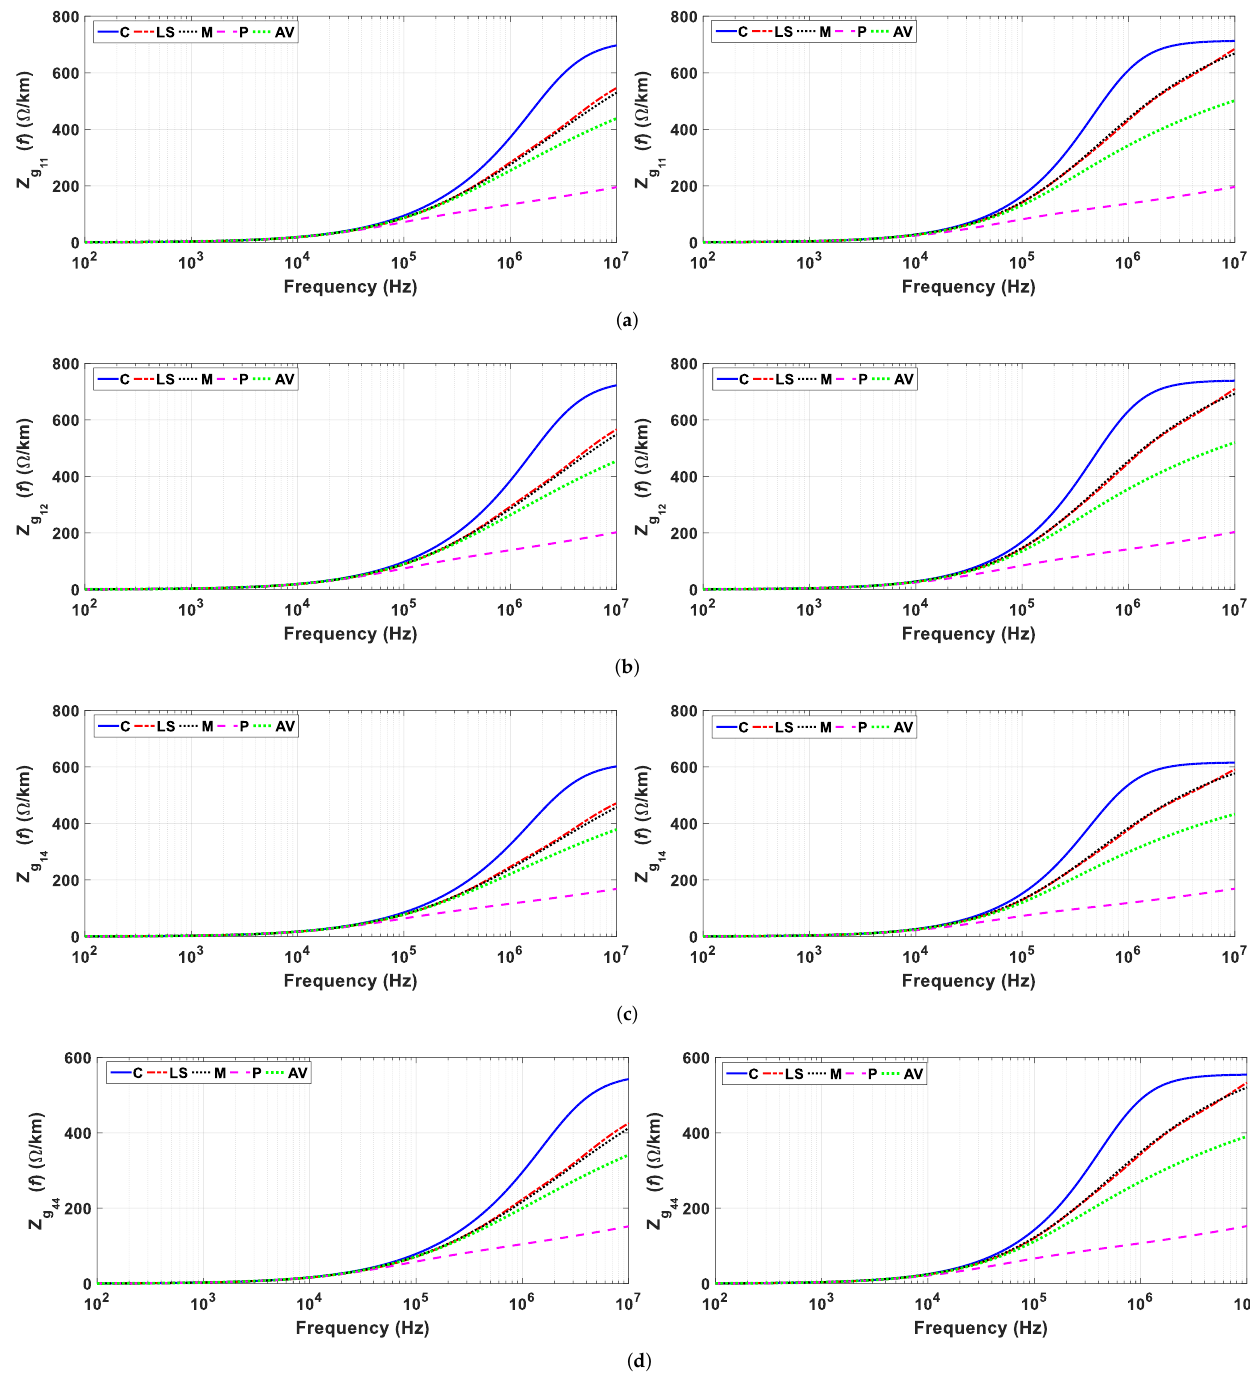
Figure 7. Magnitude of the ground-return impedance for a soil of 700 Ω · m ( left ) and 4000 Ω · m ( right ): ( a ) Z g ; ( b ) Z g ; ( c ) Z g and ( d ) Z g 11 12 14 44